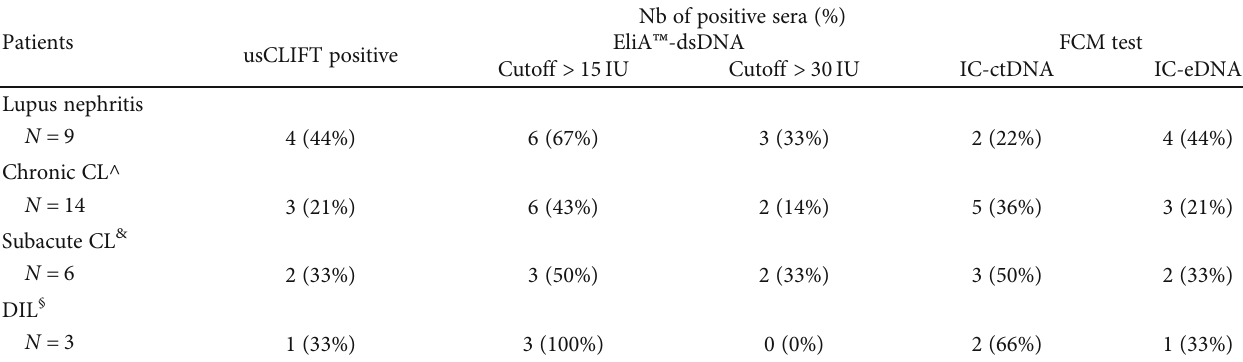
Table 2: Anti-DNA antibodies in patients with lupus nephritis or incomplete lupus erythematosus ∗ or drug-induced lupus.